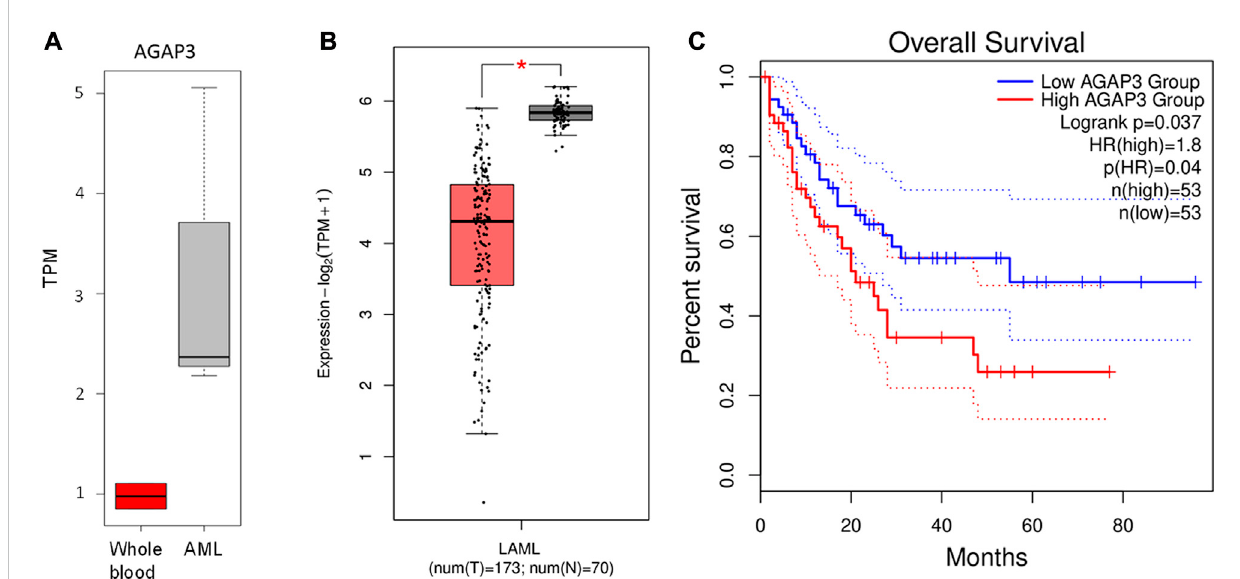
FIGURE 3 (A) Boxplot showing the difference in AGAP3 expression between control and Indian AML samples. (B) Boxplot showing a signi fi cant difference in AGAP3 expression between the AML and normal samples obtained GEPIA2 database. (C) Kaplan-Meier plot showing a signi fi cant difference in survival probabilities between low (blue) and high (red) AGAP3 expression